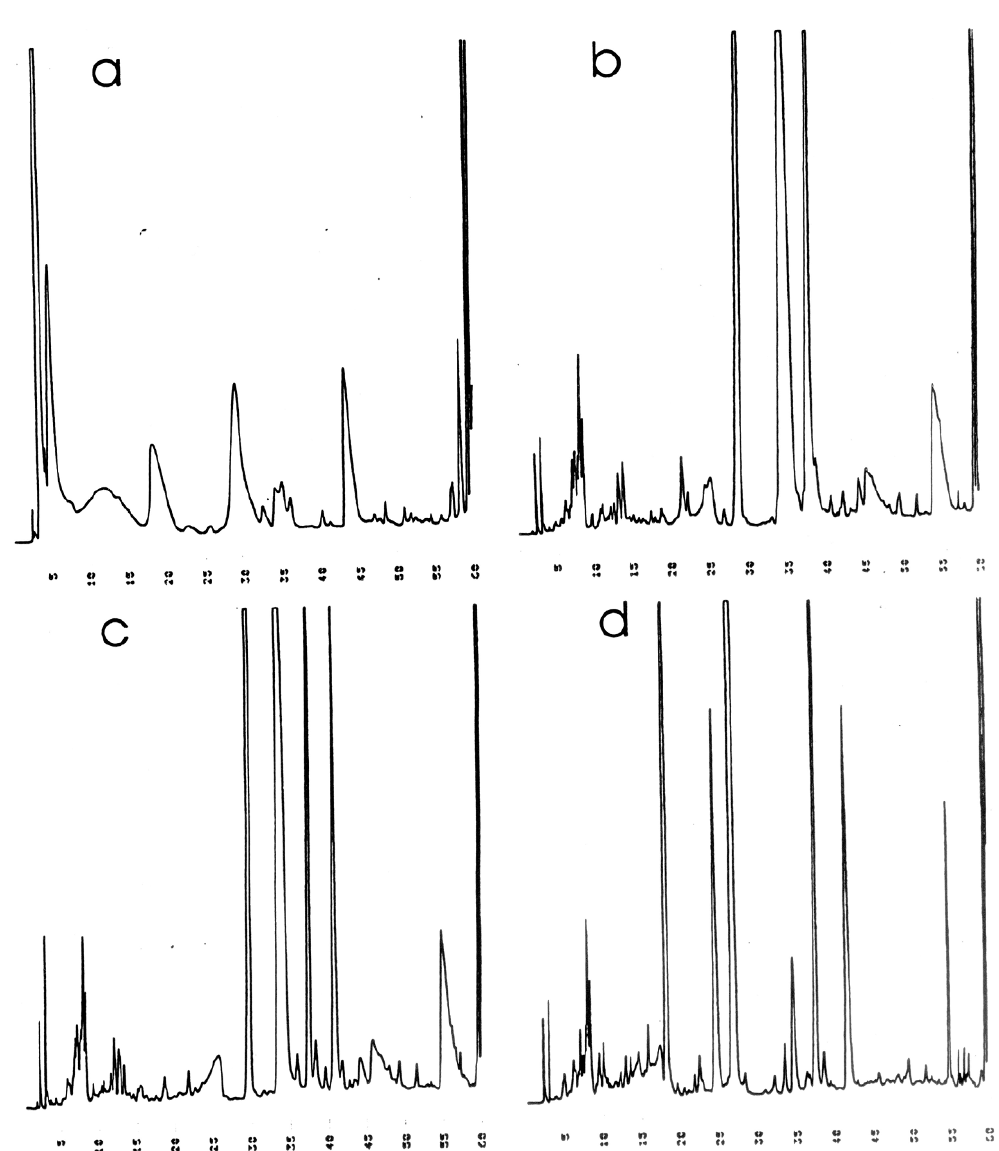
Figure 9. HPLC separation of the extracts of Rauvolfia serpentina x Rhazya stricta hybrid cell cultures (R x R17M) at day 5 after treatment with methyl jasmonate. The solvent system employed was: acetonitrile, sodium dihydrogen phosphate (3.9 mM) and hexanesulphonic acid (1.25 mM) at pH 2.5; (b) acetonitrile: sodium dihydrogen phosphate (3.9 mM) and hexanesulphonic acid (1.25 mM) at pH 5.5; and (c) acetonitrile:sodium dihydrogen phosphate (39 mM) and hexanesulphonic acid (2.5 mM) at pH 2.5